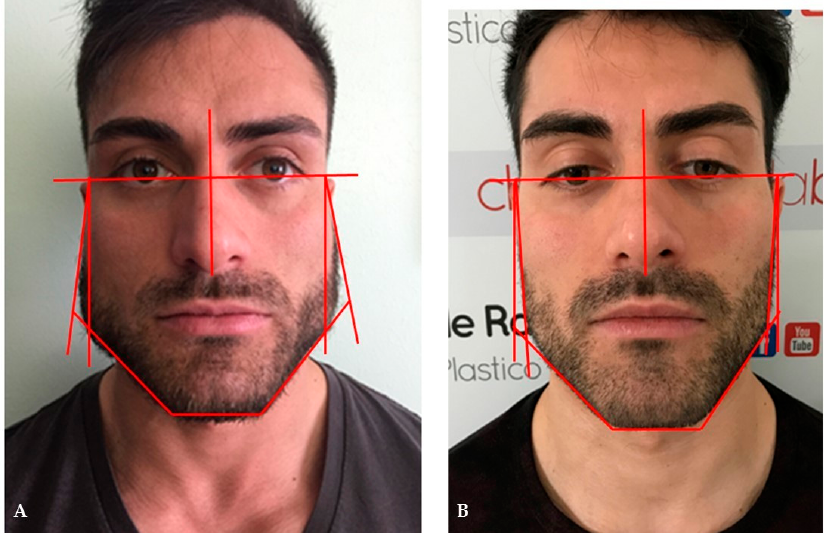
Figure 5. The angle between the zygomatic arch line and the masseter line was calculated in pre- operative picture ( A ) and 6 months post-operative picture ( B ) to assess the reduction of masseteric projection in order to achieve lower face recontouring.